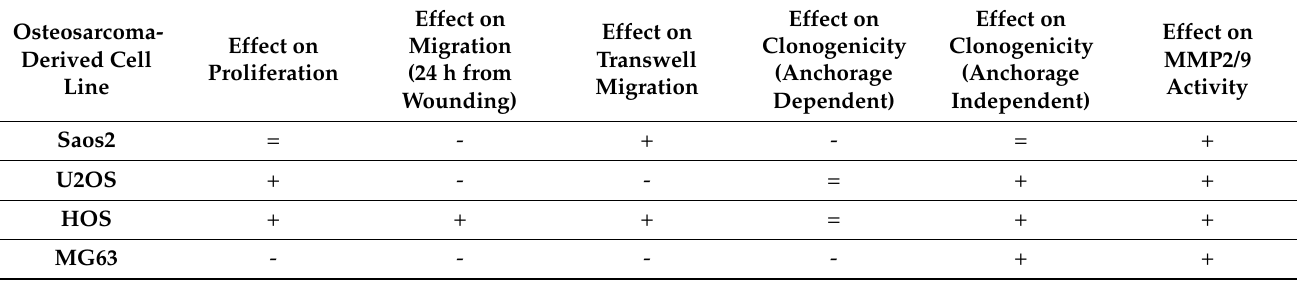
Table 1. Effects of the ectopic expression of Ankrd2 on biological functions of Ankrd2-expressing OS cell lines. Positive (+), negative (-) or not-statistically significant (=) contributions of Flag-Ankrd2 on cellular functions of Saos2, U2OS, HOS and MG63 cell lines have been reported with respect to their own parental (empty vector-transfected) counterpart.